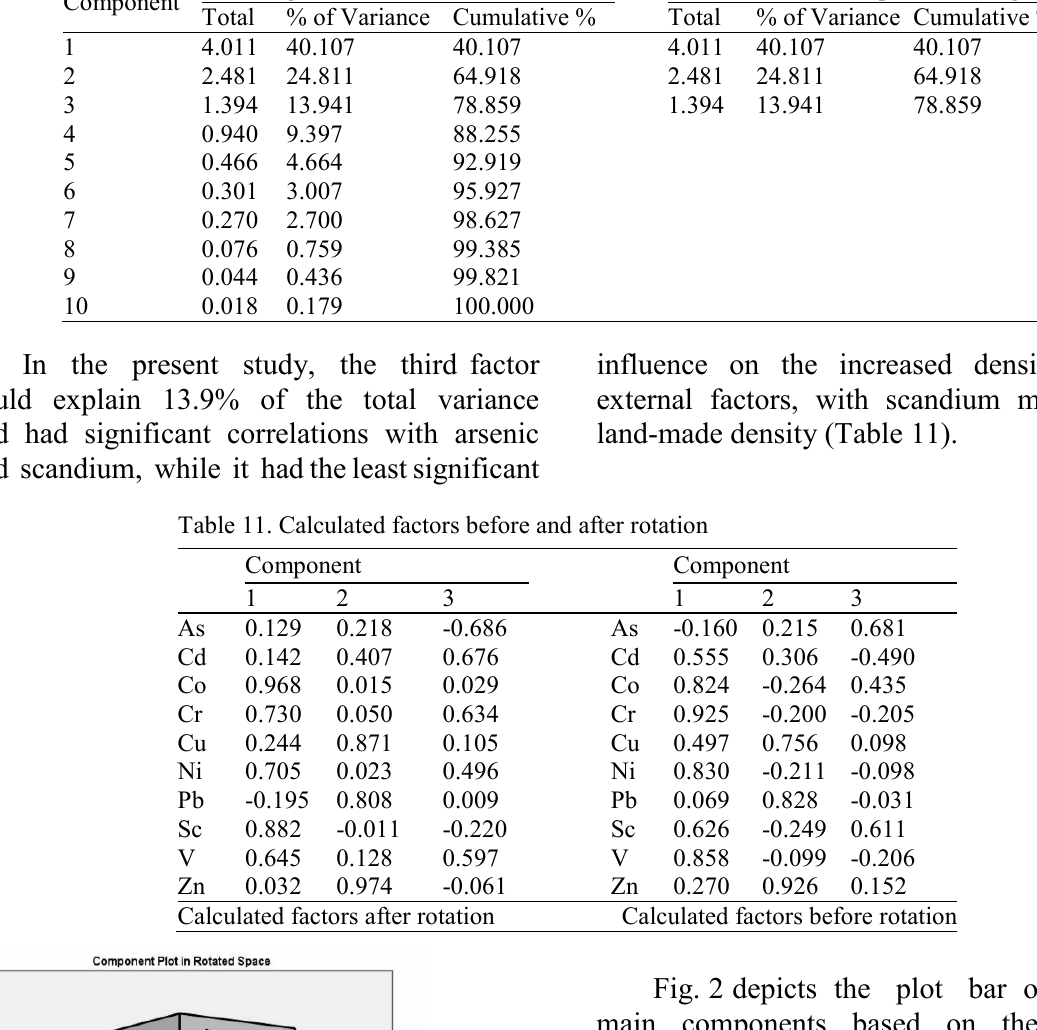
Table 10. Analysis of compounds and factor analysis of elements in studied region Initial eigenvalues Extraction sums of squared loadings Component